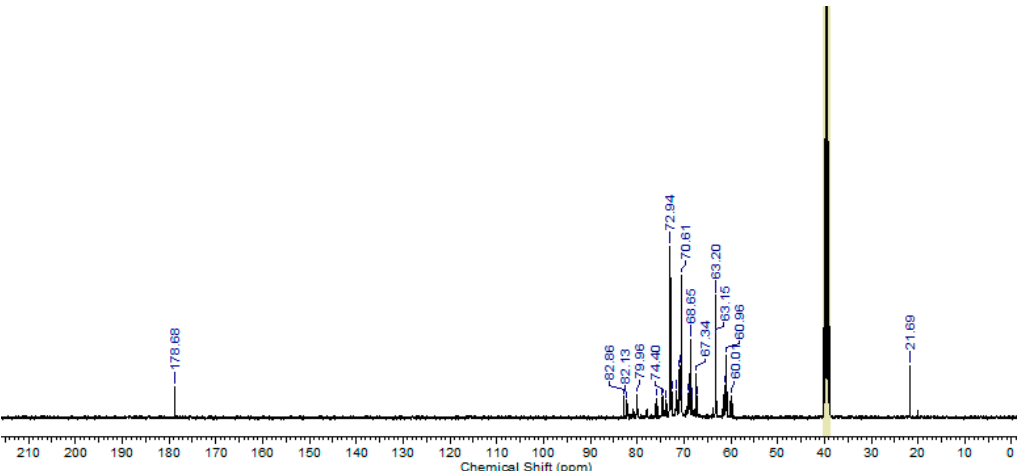
Figure 5. 13 C NMR spectrum of PGL 5/17/T12C16 post-reaction mixture. (100 MHz, DMSO-d 6 ).